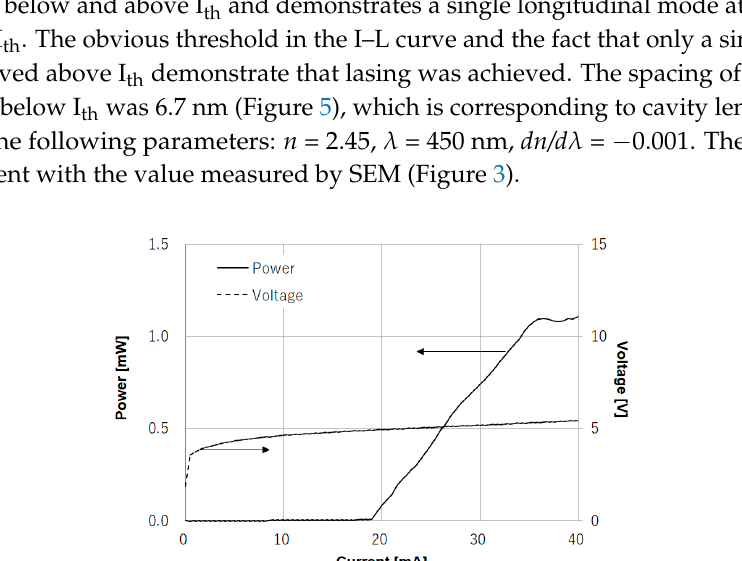
Figure 4. I–V and I–L curves generated by an all-dielectric-DBR GaN-based vertical-cavity surface- emitting laser (VCSEL). Here, I th was 18 mA and the maximum output power was 1.1 mW, the highest value reported to date for this type of device. The kinks in the I–L curve suggest multimodal operation for the lateral mode, presumably due to the absence of lateral optical confinement.